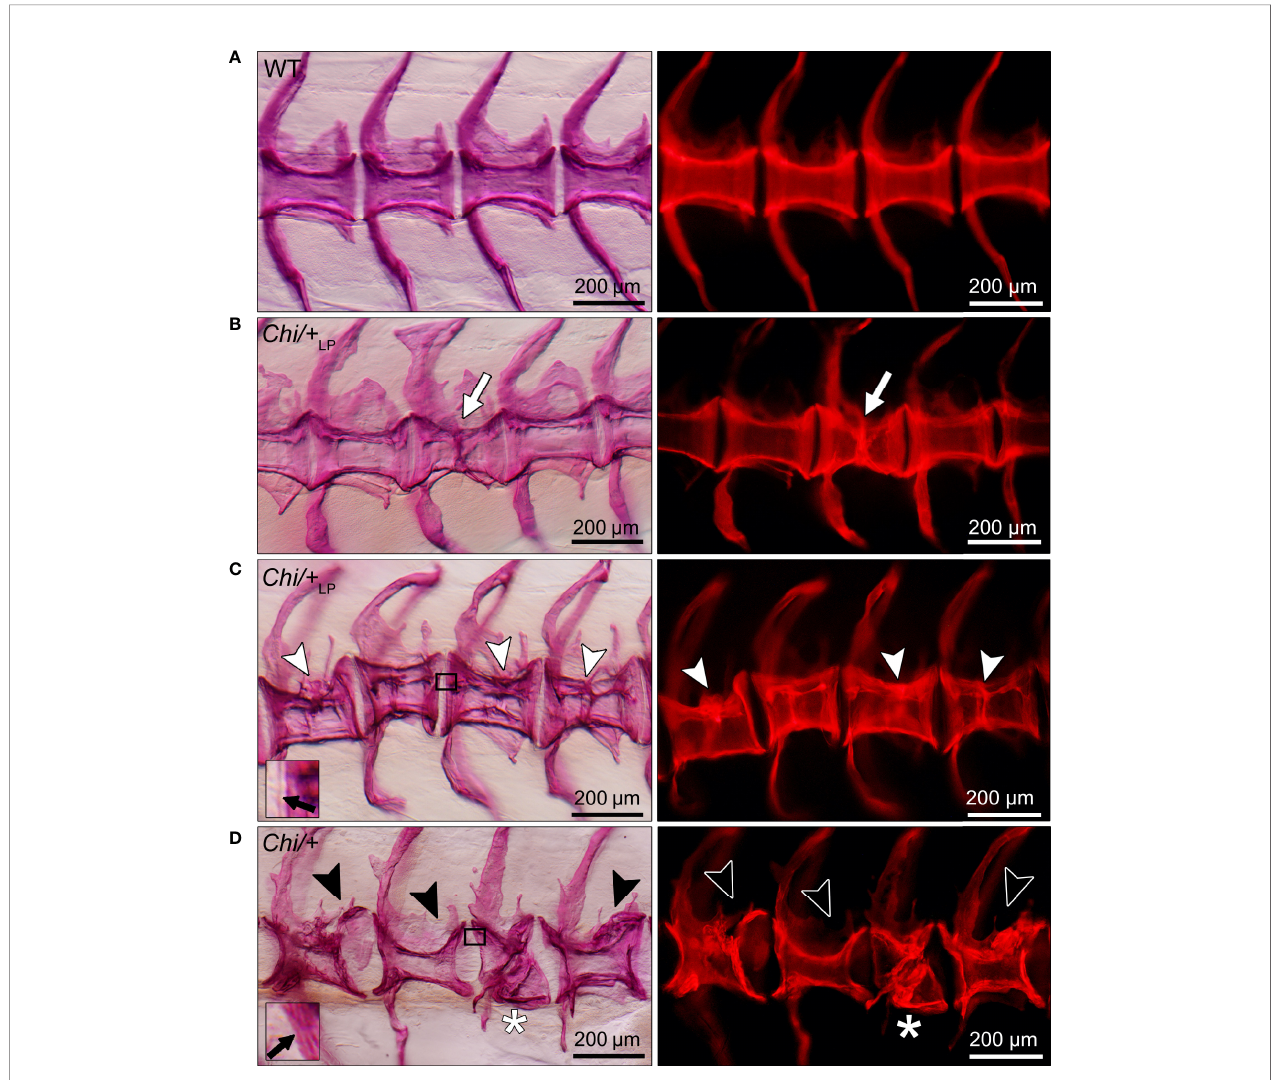
FIGURE 5 | Different grades of Chi/+ and Chi /+ LP compression fractures. Whole mount Alizarin red S stained vertebral bodies of WT (A) and mutants (B – D) visualised in bright fi eld (left) and with fl uorescence (right). Inter-individual variability and different severity levels of compression fractures are observed in three months old mutant zebra fi sh. Bone calli associated to fractures appear more dense than other bone elements when visualised with fl uorescent light. (B) Example of a mutant Chi /+ LP showing a compression fracture affecting only one vertebral body, bone callus is visible (white arrow). (C) Chi /+ LP zebra fi sh displaying kyphosis associated with multiple compression fractures and evident bone calli (white arrowheads). (D) Mutant Chi /+ fi sh displaying severely distorted vertebrae (black arrowheads) and a collapsed vertebral body (white asterisk). The inserts in (C, D) demonstrate the identi fi cation of osteoid on whole mount-stained specimens. Black arrows indicate the presence (C) and absence (D) of osteoid in Chi /+ LP and Chi /+,